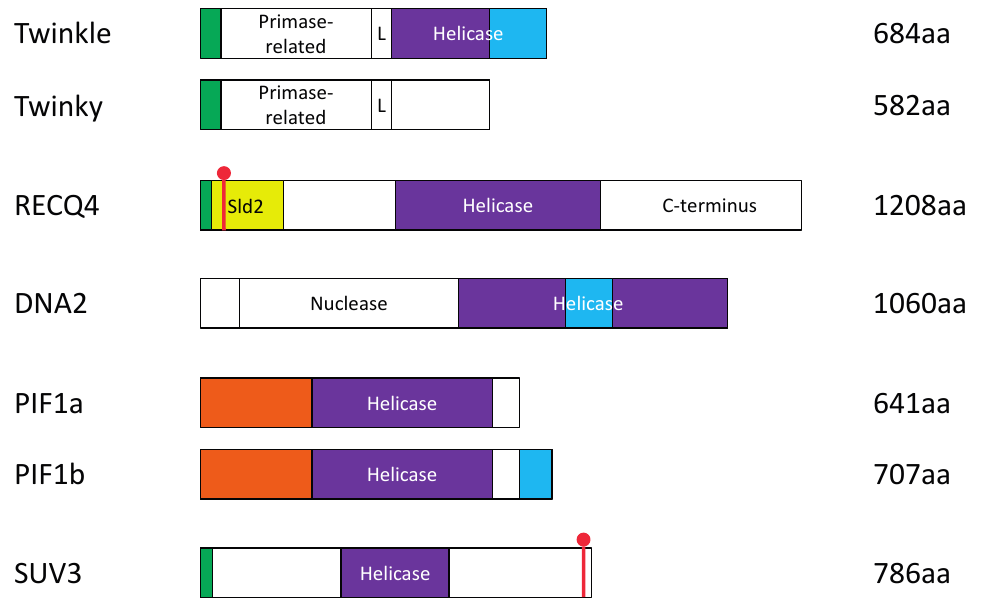
Figure 2. Schematic diagram of the protein domains and alternatively-spliced variants of the human DNA helicases that have known functions in the mitochondrion. Green: mitochondrial targeting sequence (MTS). Red: nuclear localization signal (NLS). Purple: helicase domain. Blue: non-MTS sequence required for mitochondrial localization. Brown: arginine-rich region where potential NLSs reside. Yellow: unique sld2-like domain. L = linker